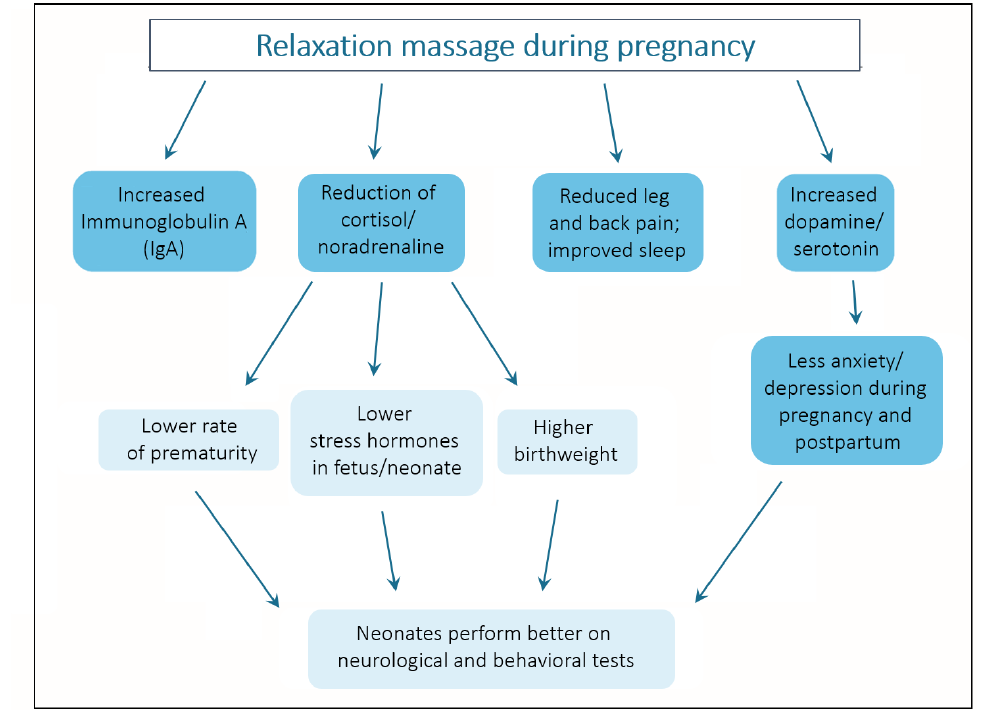
Figure 2. Effects of massage during pregnancy on mother (dark blue) and fetus (light blue).